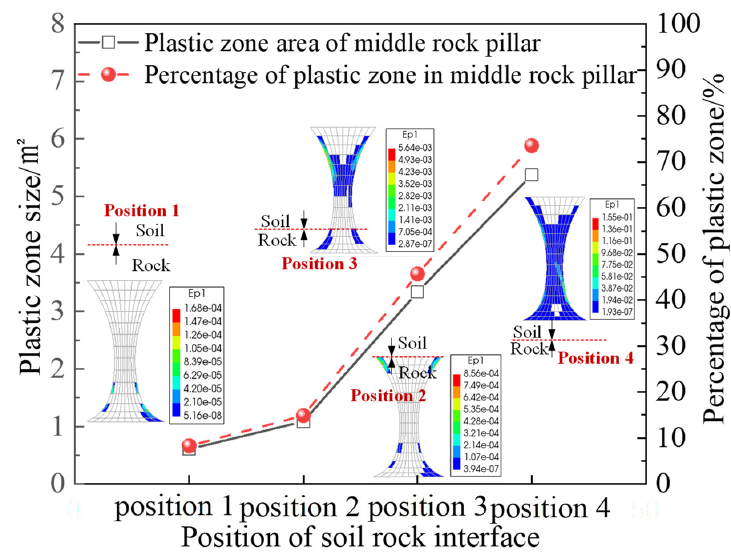
13 of 17 Figure 13. Comparison of measured bending moment with numerical simulation (unit: kN·m). 4.4.2. Variation of the Plastic Zone in the Middle Rock Pillar The soil-rock interface and the rock pillar in the soil are the main damaged parts. Take the plastic zone of the middle rock pillar under the position of each soil-rock inter- face at the burial depth of 14 m as an example, as shown in Figure 14. Figure 14 shows that with the downward movement of the soil-rock interface, the plastic zone of the mid- dle rock pillar is mainly located near the soil-rock interface and part of the soil middle rock pillar, until the plastic zone of the soil middle rock column is penetrated; at the same